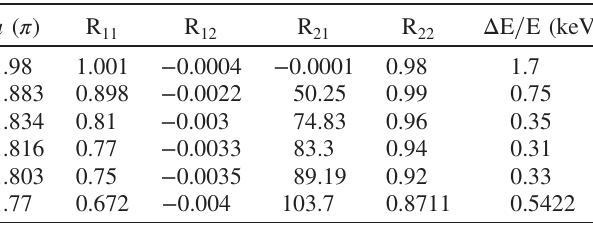
TABLE I. The solutions of nonperiodic transfer matrix for the matching section at given phase advances and resulting final energy spread values for each solution. The residual energy spread is minimized for the solution at μ ¼ 1 . 816 .